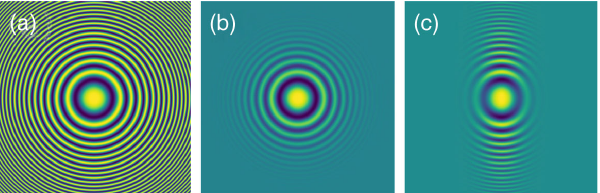
FIG. 2. Simulated single-scatterer interference pattern in the case of a filament electron beam (a), a round electron beam (b) and a horizontally elongated electron beam (c). Plots refer to Eqs. (3) and (6), namely the interference pattern generated by a single scatterer on top of the (uniform) x-ray intensity distribu- tion. The side of each square is 140 μ m. Simulation parameters: λ ¼ 0 . 1 nm, Z 30 m, z ¼ 2 m, 23 μ m (H) × 23 μ m (V) 0 ¼ electron beam in (b), 45 μ m (H) × 11 μ m (V) electron beam in